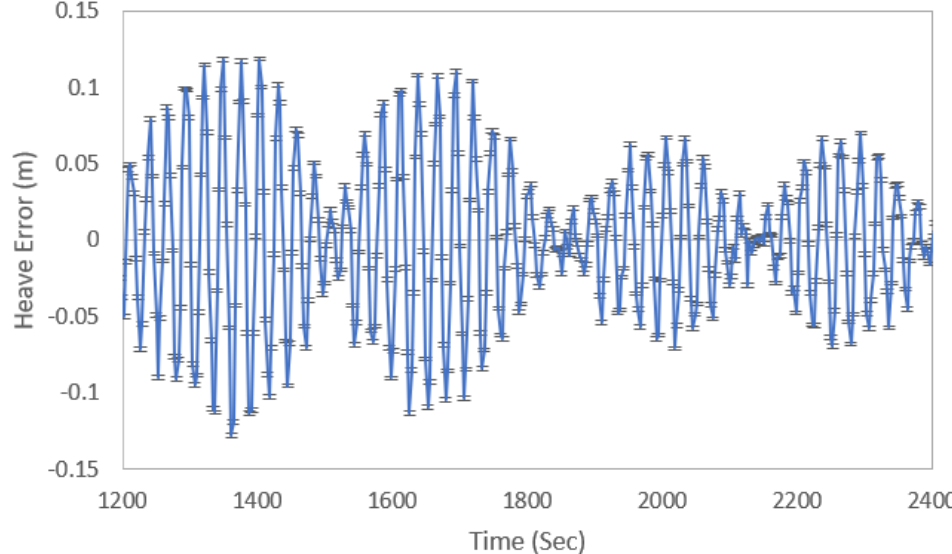
Figure 15. Heave response error between ANN and FEM model results for wave height of 9.65 m and the wave period of 9.94 s.